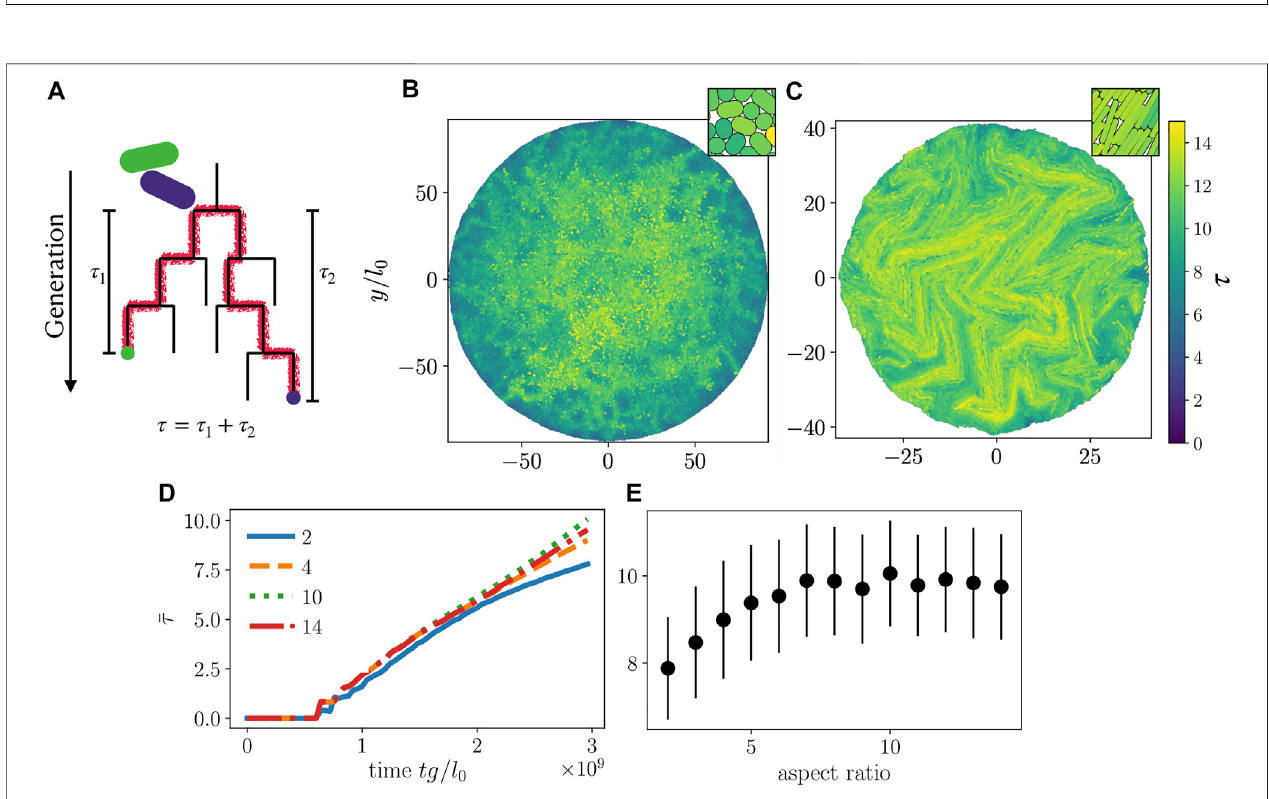
FIGURE 5 | (A) Schematic for calculation of phylogenetic distance τ . The two particles (green and purple) are neighbors. Green and purple dots mark the particles ofinterestatpresenttime,whileredlinestracetheirancestrybacktothecommonancestor. (B,C) τ calculatedforeachcellincolonieswithcellaspectratio (B) 2and (C) 10. Insets in (B,C) show a magni fi ed view of the center of each colony. (D) Colony average (cid:1) τ ofphylogenetic distance asa function oftime for particlesof various aspect ratios as given in the legend. (E) (cid:1) τ at the end of our simulations for a range of aspect ratios (from a single simulation run per aspect ratio). The error bars are the standard deviations of (cid:1) τ in each